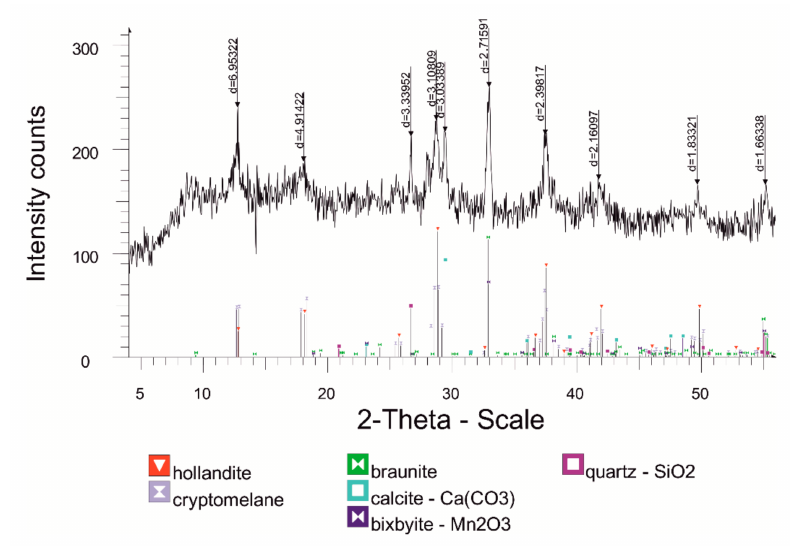
Figure 8. Diffractogram of manganese ore sample from the Bogach